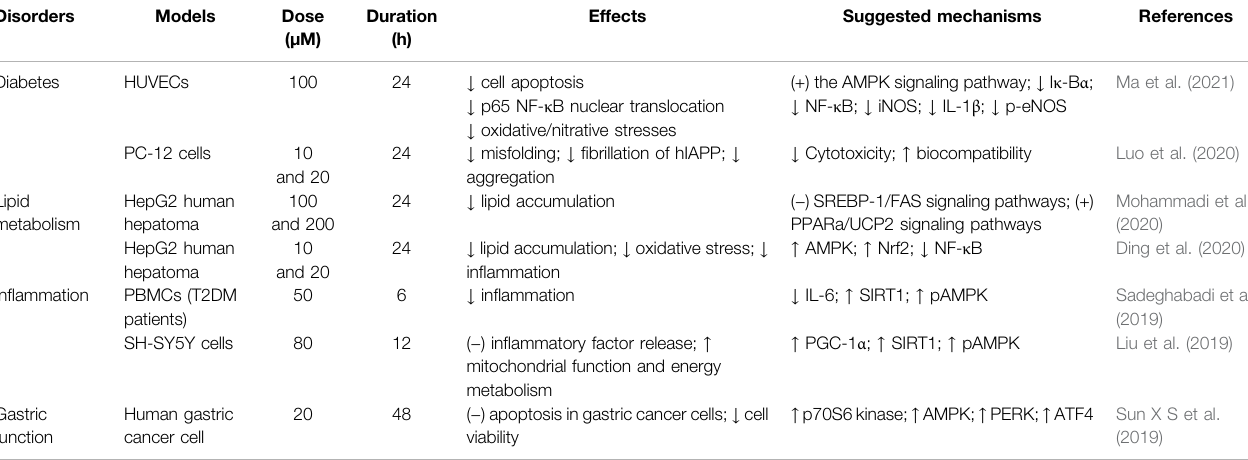
TABLE 4 | In vitro effects of chicoric acid in the treatment of various disorders.